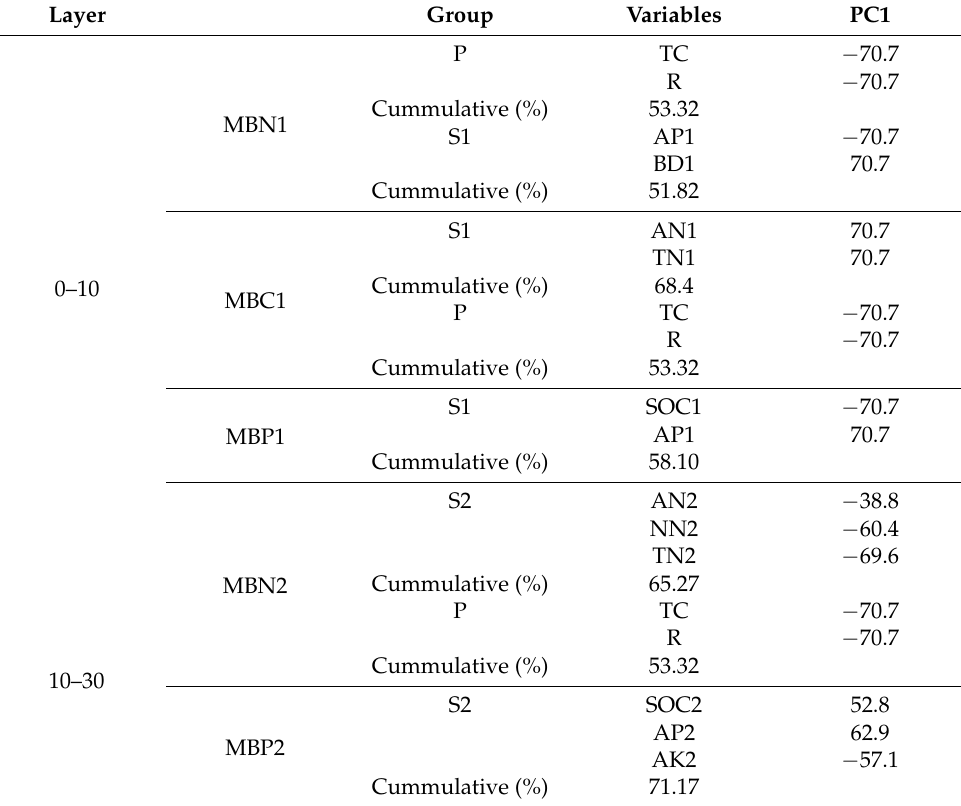
Table 2. Results of principal components analysis (PCA) of plant and